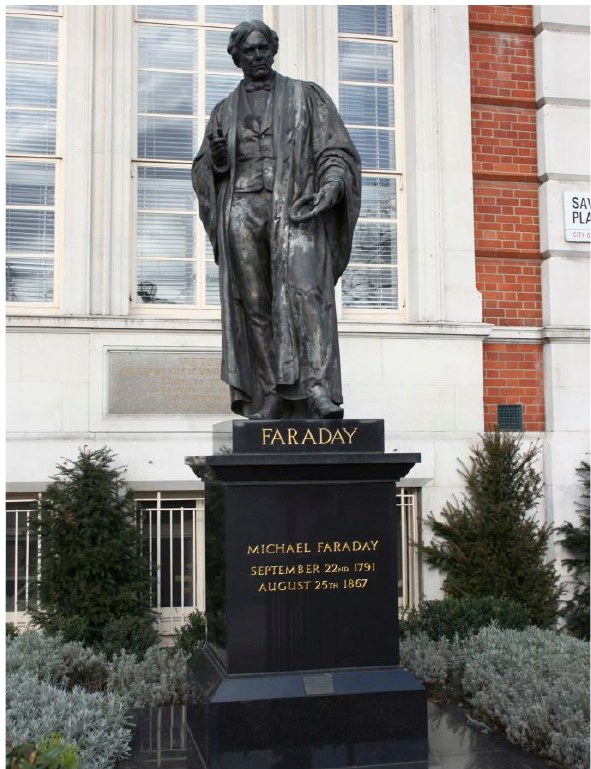
Figure 20. Statue of Michael Faraday in Savoy Place, London [26].